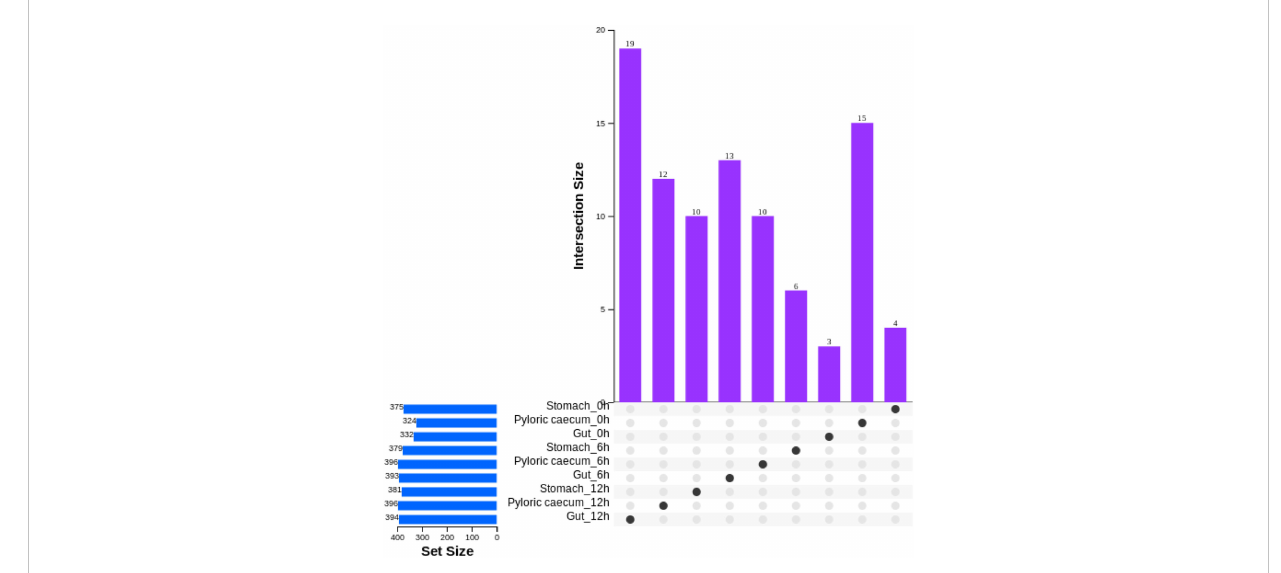
FIGURE 6 The characteristic of genera numbers in each gastrointestinal tissue of pond-cultured Japanese fl